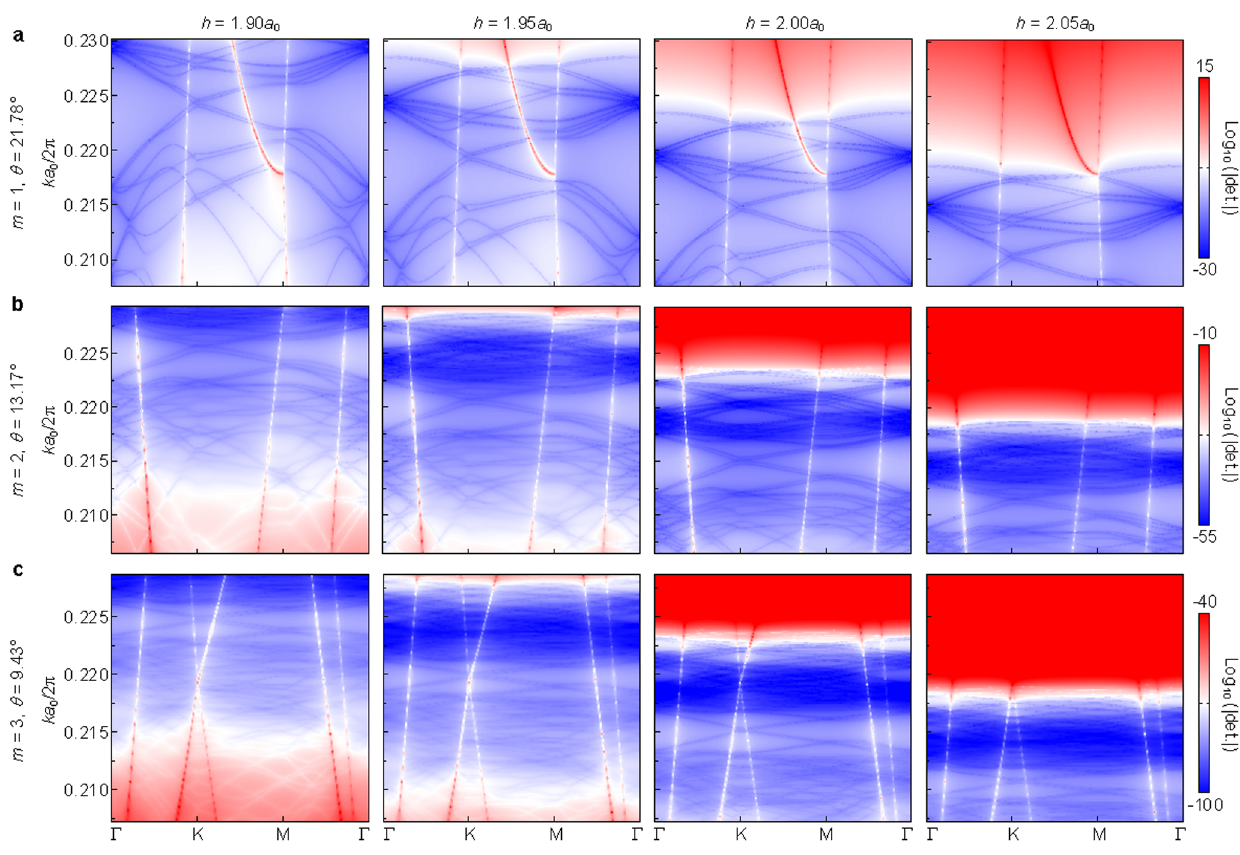
Fig. 3 Dispersion relation of the holey twistsonic medium with different plate thickness h and twist angles. We vary the plate thickness ( h = h 1 = h 2 ) from h = 1.90 a 0 to h = 2.05 a 0 (four columns) and twist the bilayer according to a m = 1 ( θ = 21.78 ∘ ), b m = 2 ( θ = 13.17 ∘ ), and c m = 3 ( θ = 9.43 ∘ ). The gap separation is fi xed at h g = 0.8 a 0 .